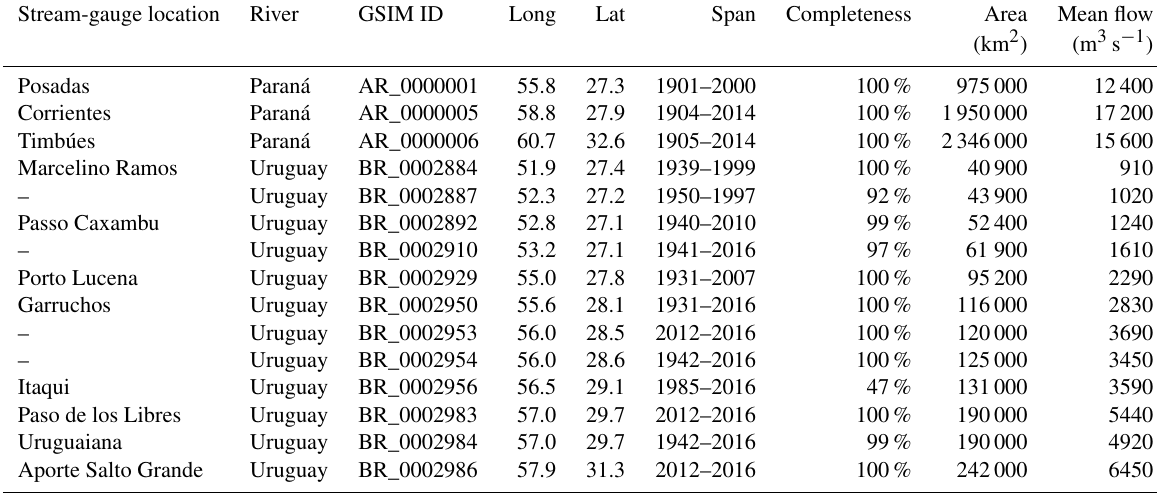
Table 1. GSIM river-gauge records (Do et al., 2018; Gudmundsson et al., 2018a; Fig. 3). Long and Lat are degrees west longitude and south latitude, respectively. Completeness is the percentage of years during the span featuring data. Area is the gauged drainage area. Mean flow is the time mean streamflow over the record length.